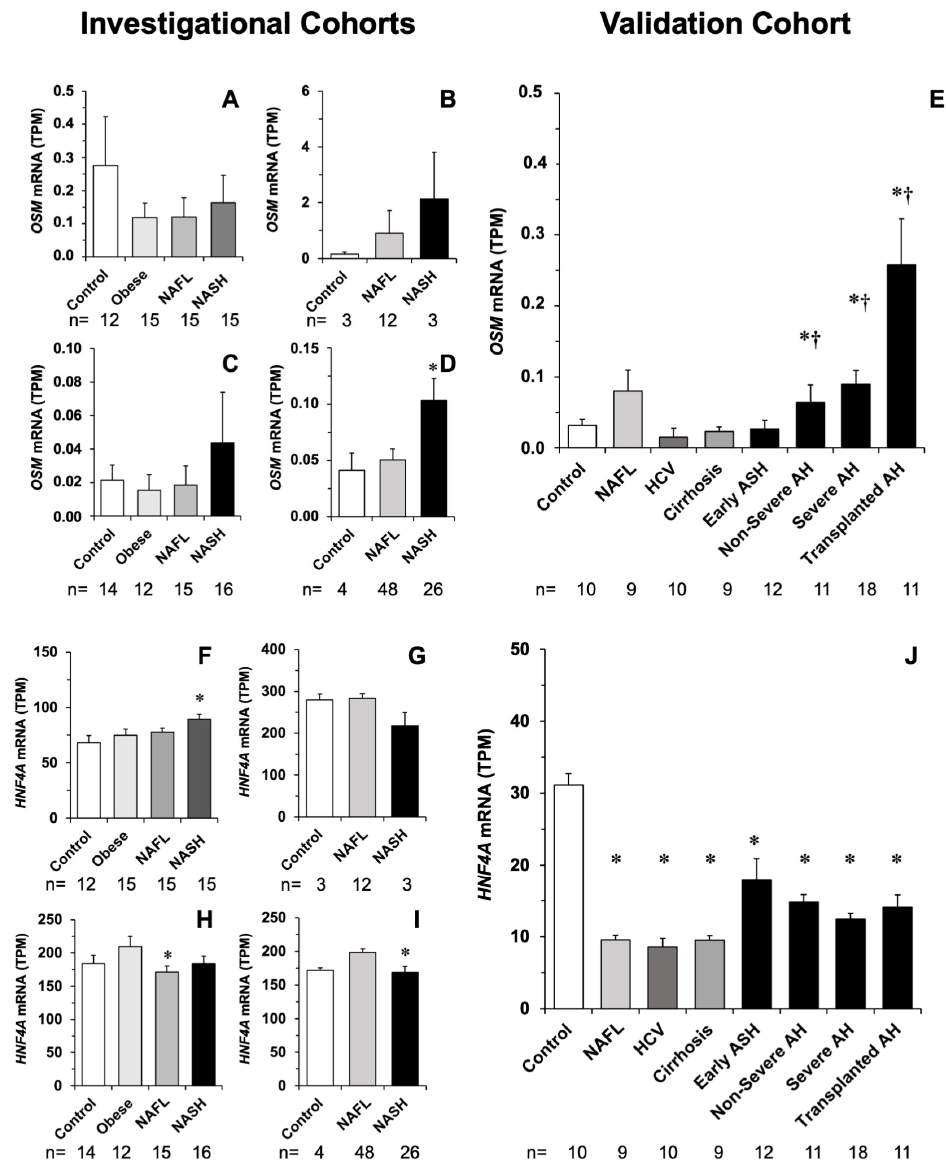
Figure 6. Abundance of OSM and HNF4 α mRNA (TPM) in the liver of patients belonging to four investigational cohorts, whose information is available in databases GSE105127 ( A , F ), GSE115193 ( B , G ), GSE126848 ( C , H ) and GSE130970 ( D , I ). Determination of mRNA abundance by similar methods in a validation cohort with different liver diseases ( E , J ). ANOVA, followed by the Bonferroni method of multiple-range testing was used for statistical analysis. *, p < 0.05 as compared with Control; †, p < 0.05 as compared with Early ASH.